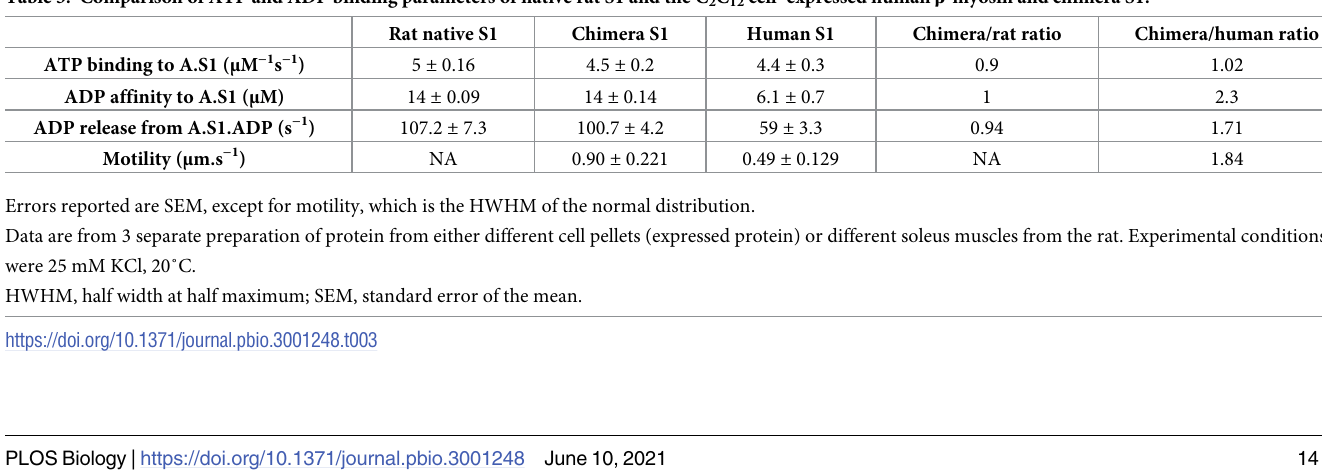
Table 3. Comparison of ATP and ADP binding parameters of native rat S1 and the C 2 C 12 cell–expressed human β -myosin and chimera